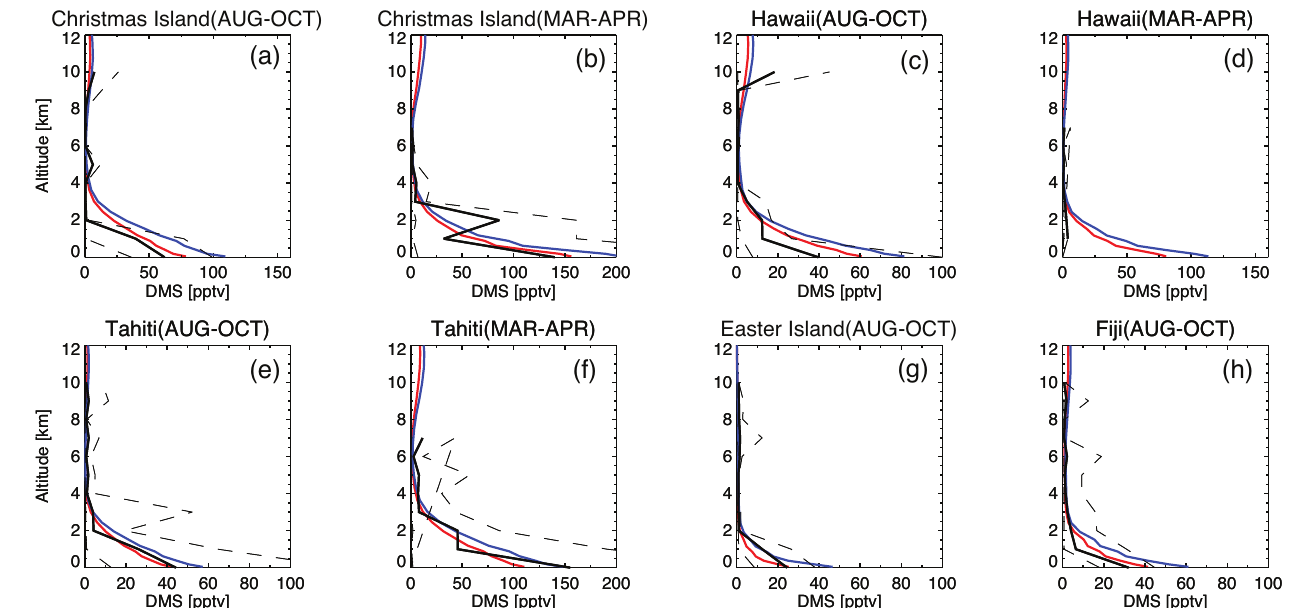
Figure 4. Comparison of DMS vertical profiles over the Pacific Ocean, simulated (red for ModelE2-TOMAS and blue for ModelE2-OMA) and observed (black solid line). Observations are from PEM-Tropic-A (August–October 1996 in the tropical Pacific; Christmas Island in a ; Hawaii in c ; Tahiti in e ; Easter Island in g ; Fiji in h ) and PEM-Tropic-B (March–April 1999 in the tropical Pacific; Christmas Island in b ; Hawaii in d ; Tahiti in f ). The dashed lines represent 25th and 75th percentiles of the observed